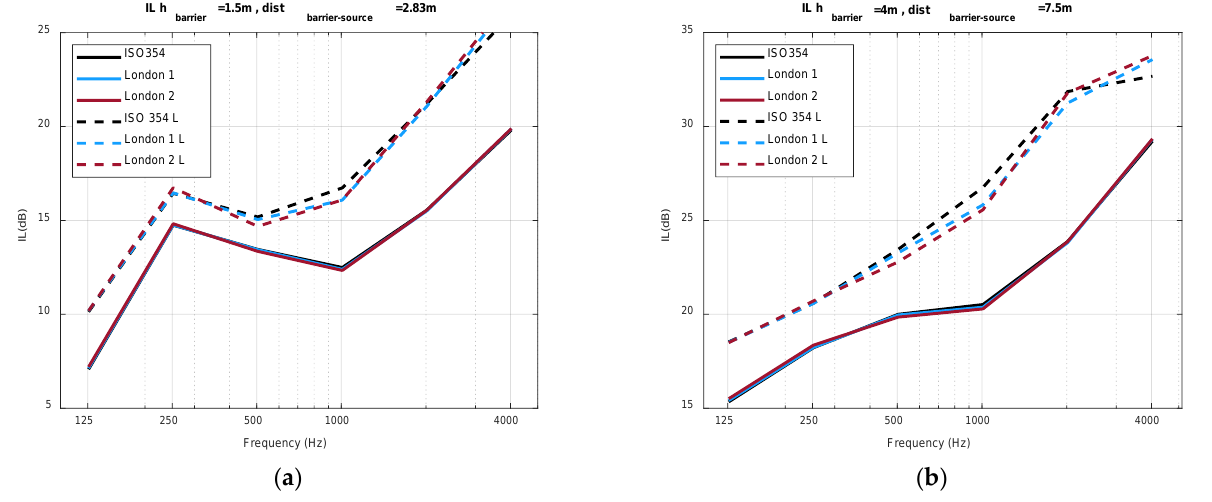
Figure 17. Insertion loss curves calculated with the BEM methodology, with the porous concrete sound absorption derived from ISO 354 experimental test, and London 1 and London 2 equations, for noise barriers with heights of: ( a ) 1.5 m and ( b ) 4 m. Dashed curves correspond to L-shaped cantilevered barrier, and continuous lines to a vertical barrier.